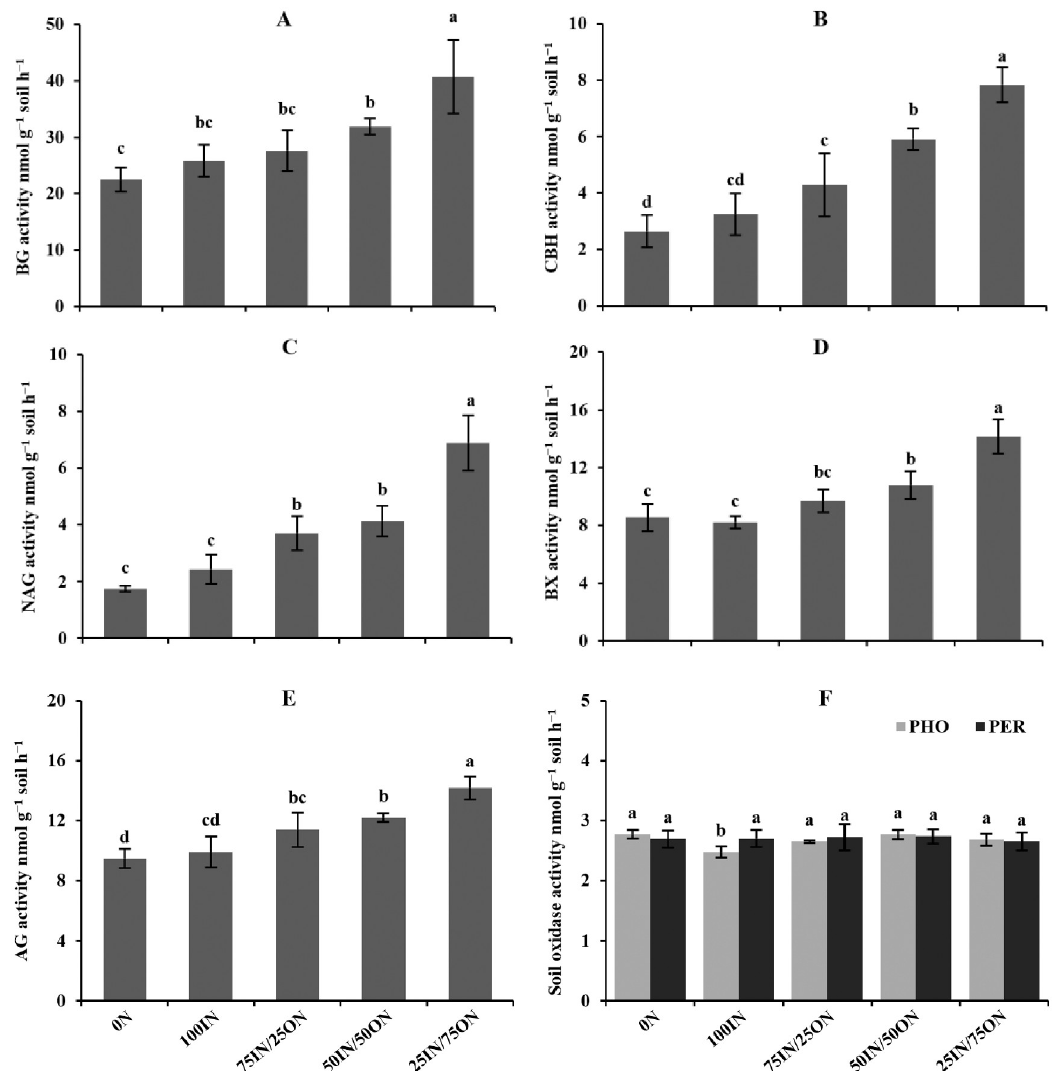
Fig 2. Changes in soil extracellular enzyme activities (A: BG activity; B: CBH activity; C: NAG activity; D: BX activity; E: AG activity and F: Soil ox idase activity) under different fertilization treatments. AG α -Glucosidase, BG β -Glucosidase, CBH β - Cellobiosidase, BX β -Xylosidase, NAG N-Acetyl-glucosaminidase, PHO Phenol oxidase, PER Peroxidase.